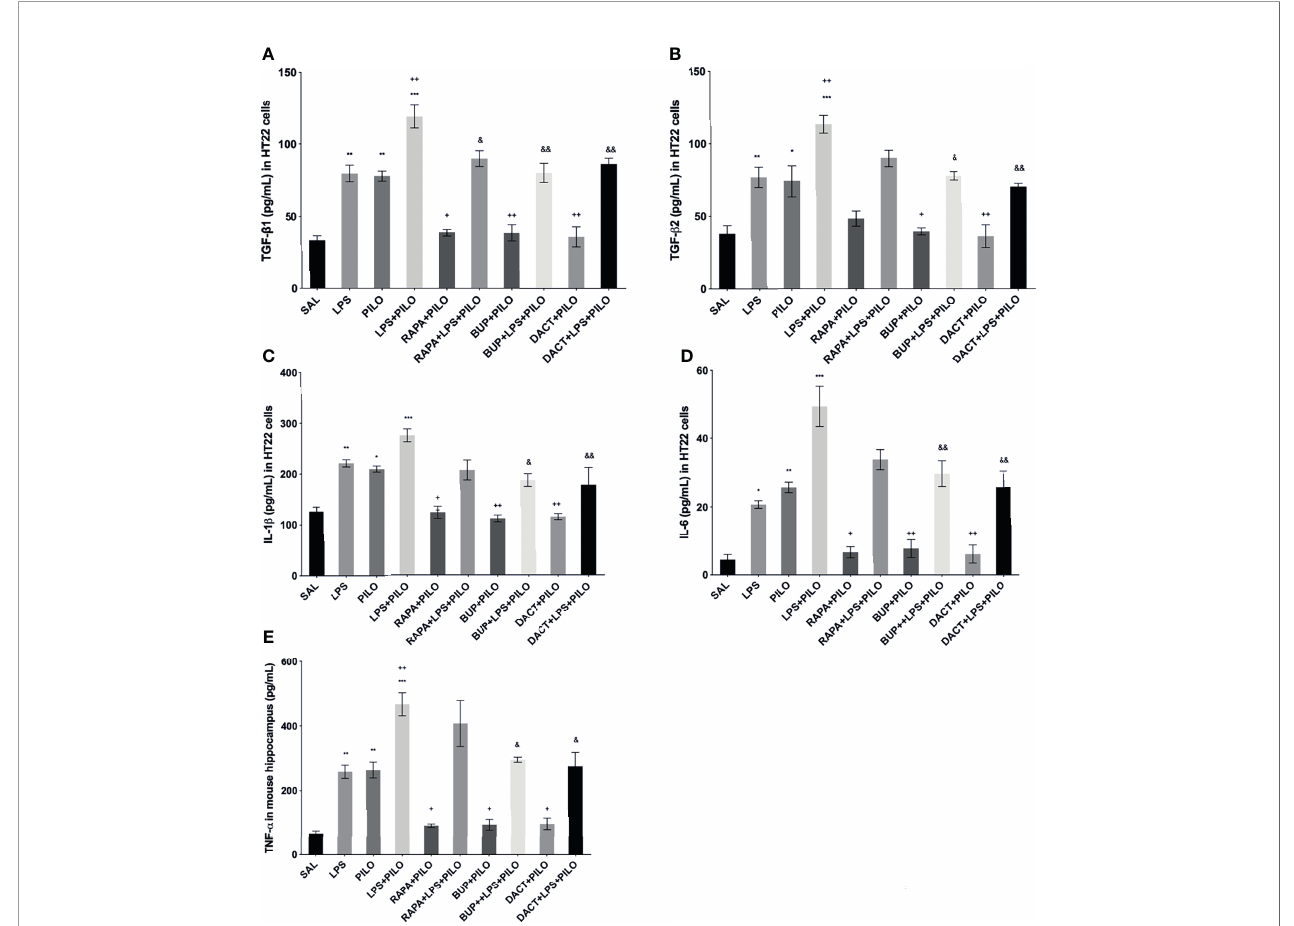
FIGURE 4 | Effects of RAPA, BUP, and DACT on cytokine signaling in HT-22 cells. The cytokine levels (pg/ml) in the above fi gure were measured in cellular lysates. The fi gure is represented as effects on the levels of (A) TGF- b 1, (B) TGF- b 2, (C) IL-1 b , (D) IL-6, and (E) TNF- a . The data are represented as mean ± SEM (n = 6) and analyzed by one-way ANOVA followed by Tukey Kramer multiple comparison tests. The signi fi cance is ascertained as ***p < 0.001 versus SAL, **p<0.01 versus SAL, *p<0.05 versus SAL, && p<0.001 versus LPS+PILO, & p<0.05 versus LPS+PILO, ++ p<0.01 versus PILO, and + p<0.05 versus